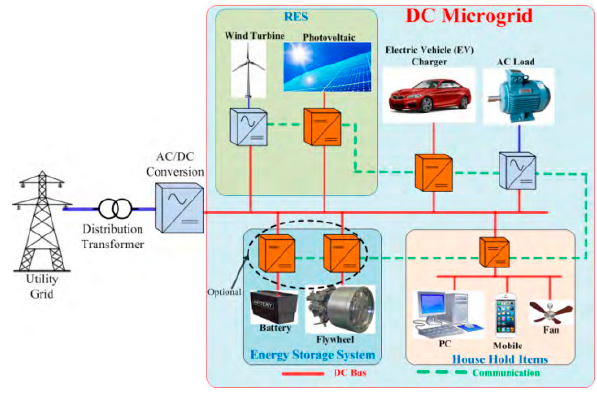
Figure 1. Distributed energy resources (DERs) connected in a DC Microgrid (MG) [7].